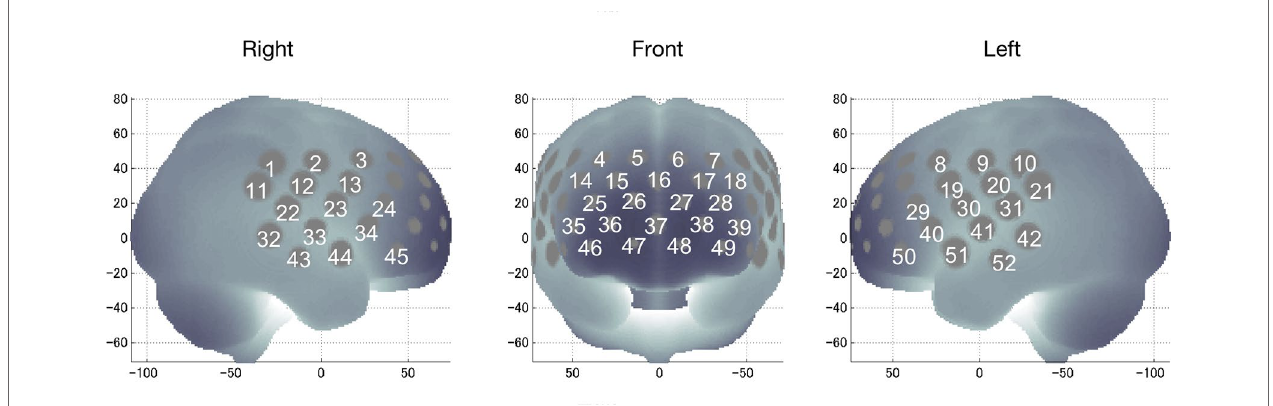
FIGURE 1 | Locations of near-infrared spectroscopy channels for recording functional hemodynamics in the frontotemporal area (dorsolateral prefrontal, ventrolateral prefrontal, frontopolar, and temporal